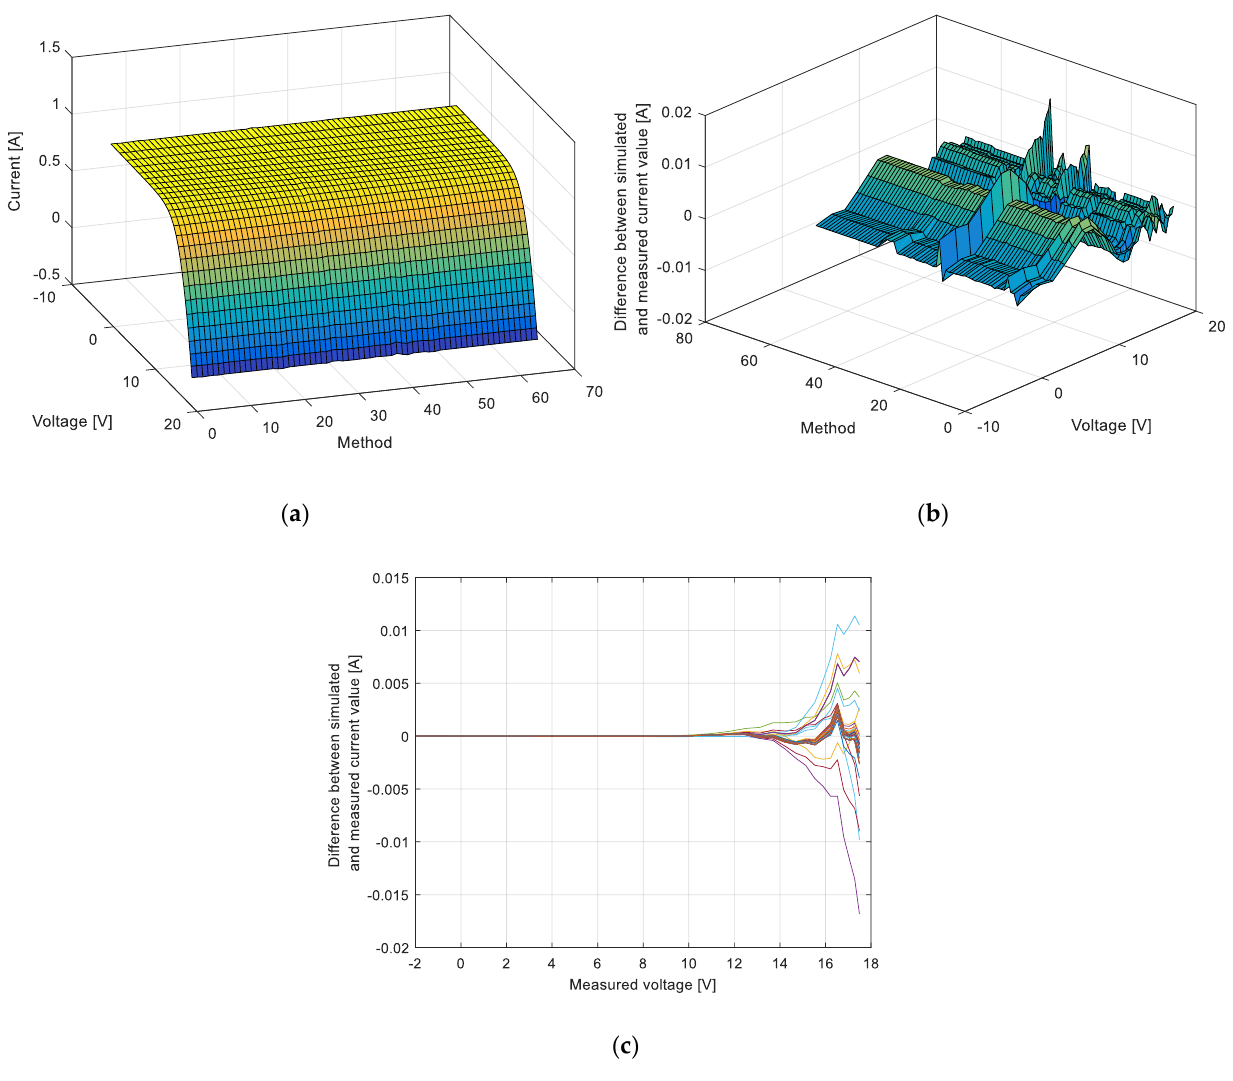
Figure 5. Photowatt-PWP201 module: ( a ) current-voltage characteristics; ( b ) the corresponding error; ( c ) error in the current values versus the measured voltage for all